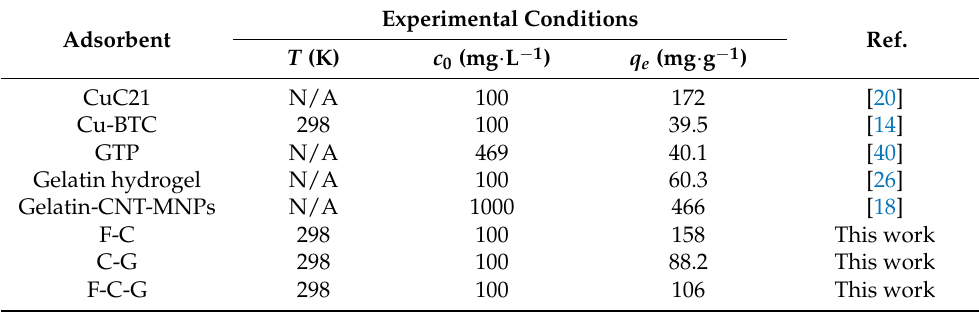
Table 4. Comparison of MB with different adsorbents.